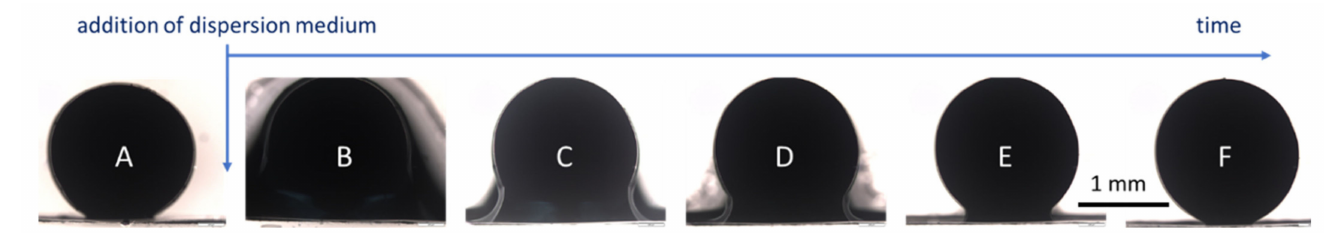
Figure 9. Microscopic images (magnification 100-fold) of a zircon dioxide bead connected to a glass surface via an aqueous meniscus that was formed upon the addition of surfactant solution. Detailed explanations c.f.